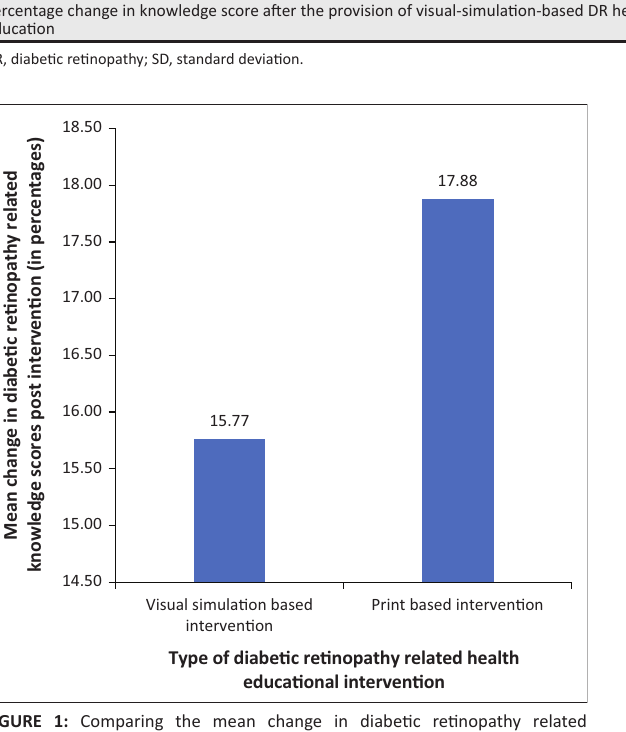
FIGURE 1: Comparing the mean change in diabetic retinopathy related knowledge scores post health educational intervention of visual-simulation- based over print-based